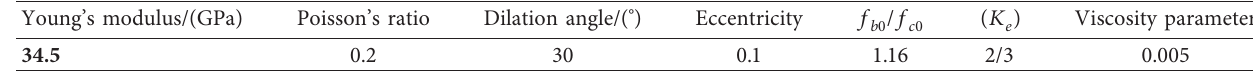
Table 5: Coefficients in CDP for concrete.